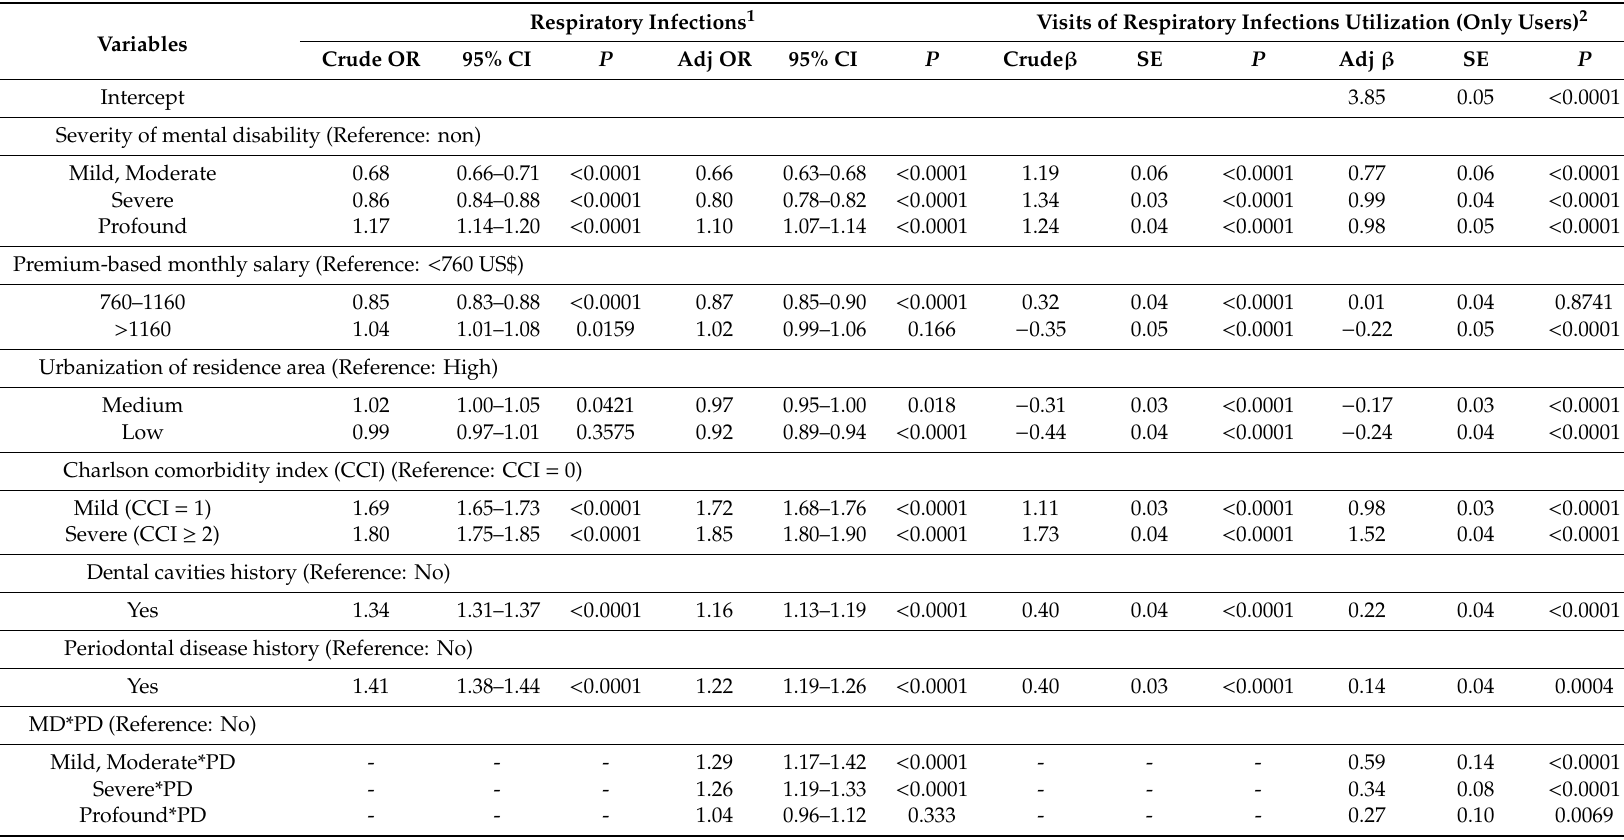
Table 3. Influential factors for respiratory infections utilization among individuals in the mental disabilities and reference